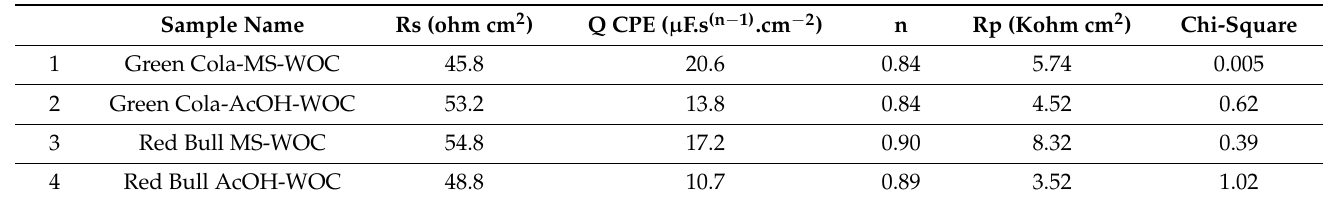
Table 2. R1—solution resistance, Q CPE—double layer capacitance (constant phase element), n— exponent, Rp—charge transfer resistance; these are the parameters of electrochemical impedance for uncoated Green Cola and Red Bull samples.